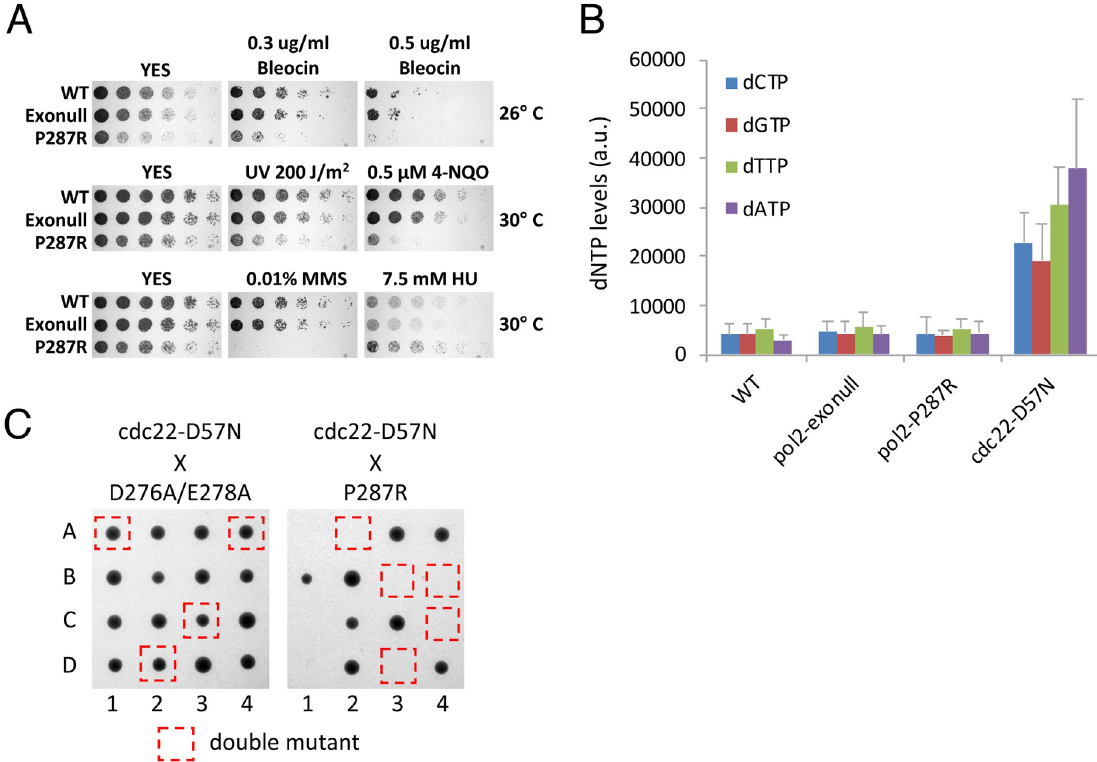
Fig 4. The pol2-P287R strain is sensitive to DNA-damaging agents and increased dNTP levels. (A) Spot assays to assess sensitivity to DNA-damaging agents of wild-type, exonull and pol2-P287R strains. 1:5 serial dilutions of the indicated strains were spotted on YES plates supplemented with 0.3 and 0.5 μ g/ml Bleocin, 0.5 μ M 4-NQO, 0.01% MMS, 7.5 mM HU or no drug and incubated at 26˚ or 30˚C for 2–3 days. (B) dNTP levels of the indicated strains measured from samples of exponential growing cells. Means ± SEs of three experiments are shown. The cdc22-D57N mutant, where allosteric regulation of RNR is inactivated, is shown as a positive control. Numerical data are in S7 Table. (C) Tetrad dissection of genetic crosses of between cdc22-D57N and pol2 mutants. Representative spores from four asci are shown for each